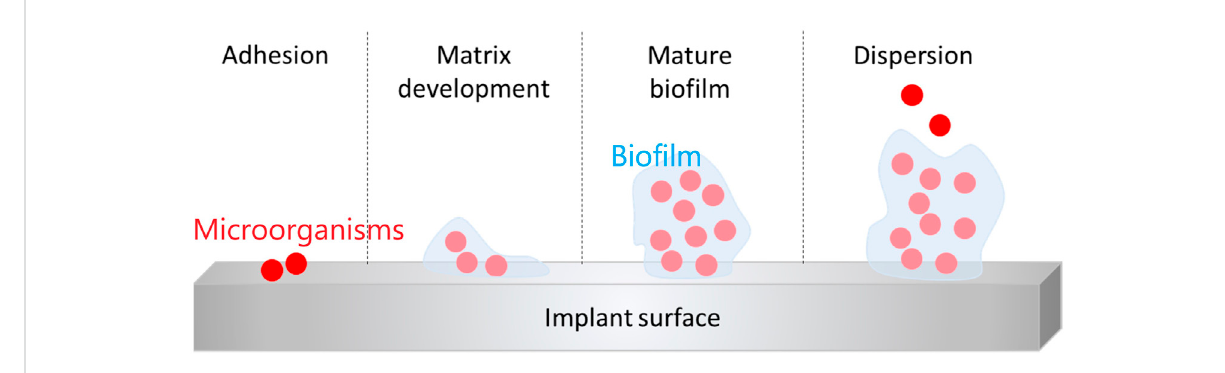
FIGURE 1 Schematic preparation of the steps of bio fi lm formation (Bistol fi et al., 2019)., Copyright 2019,